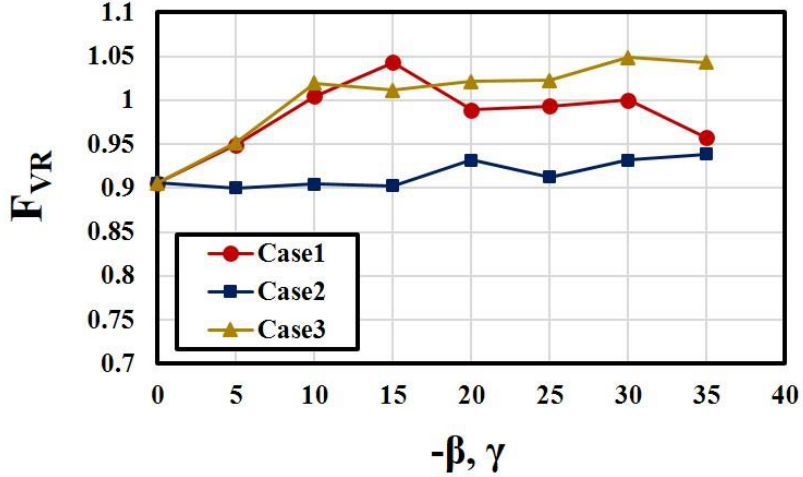
Figure 9. Variations of peak velocity ratio with pitch and/or bending angles of fluidic oscillators.